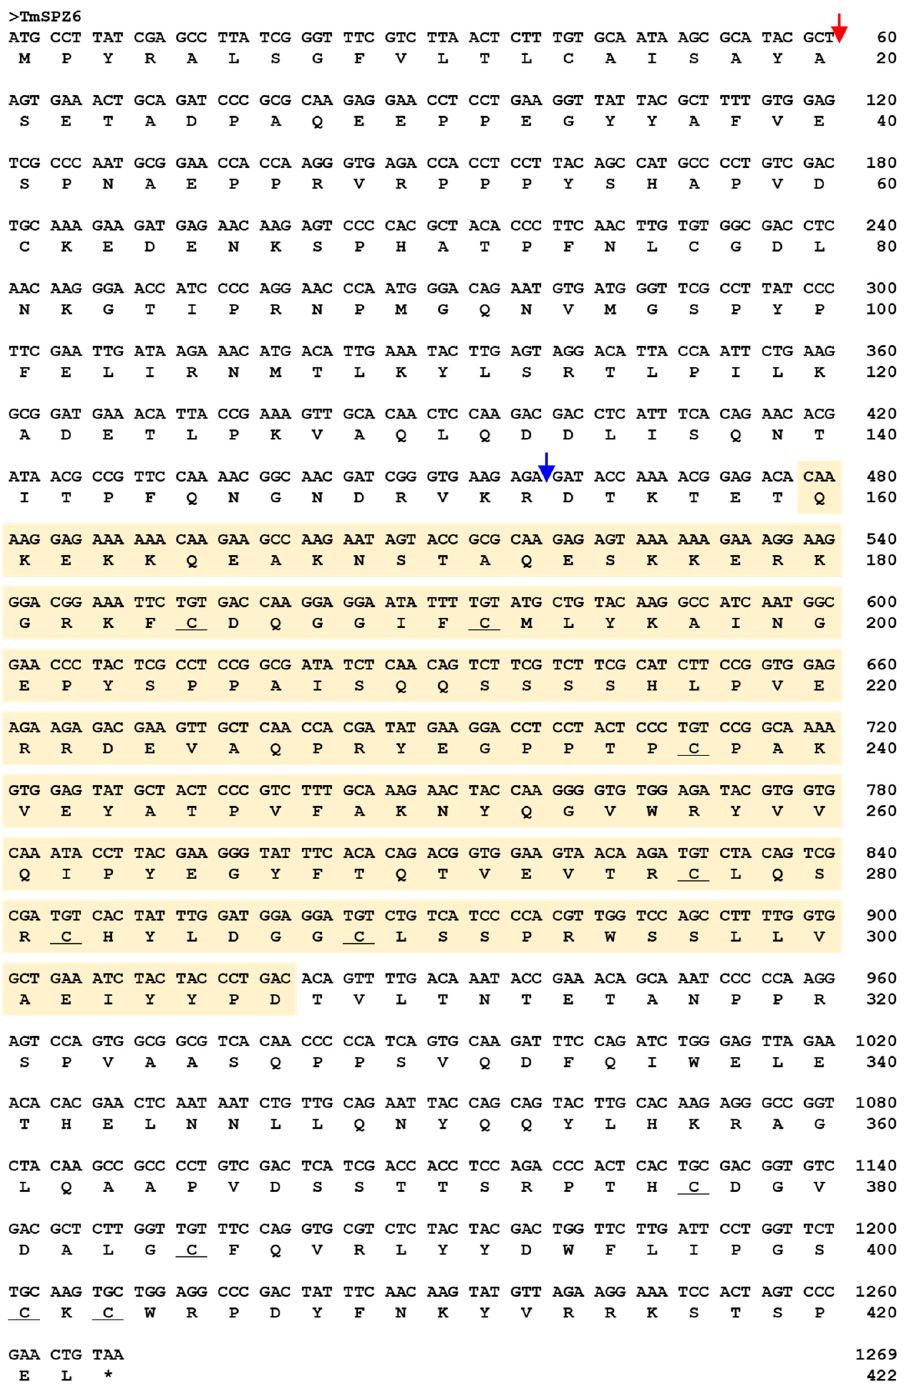
Figure 1. Nucleotide and deduced amino acid sequences of TmSpz6. It consists of a 1227 bp open reading frame encoding a 408 amino acid residue protein. Domain analysis showed that Tm Spz6 includes one cystine-knot domain (yellow box), one signal peptide (red arrow), and one cleavage site (blue arrow).